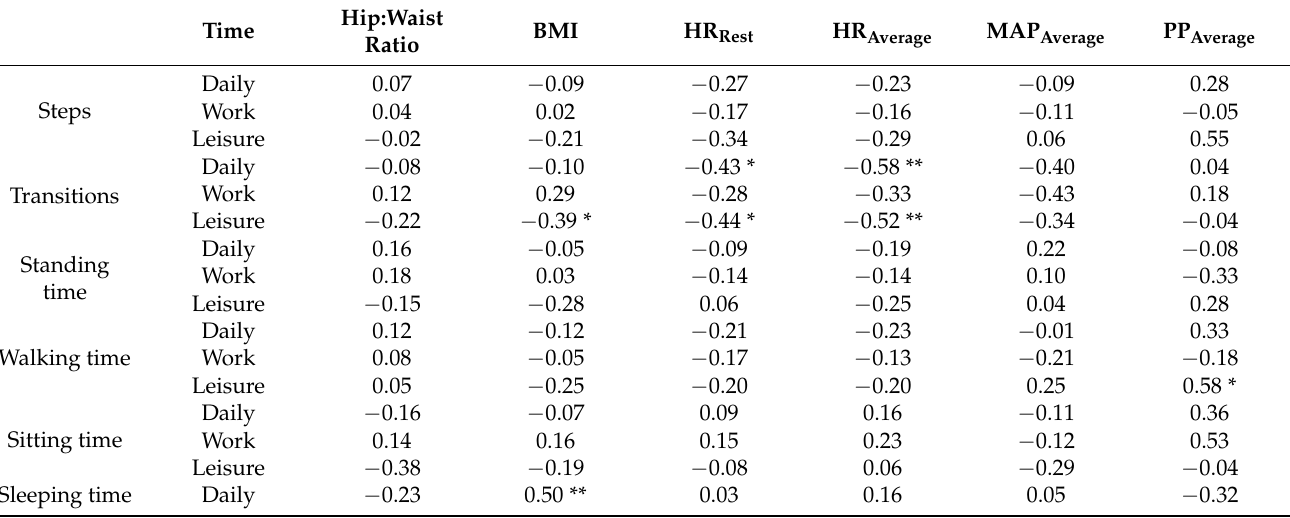
Table 6. Spearman correlations between activity levels and cardiometabolic